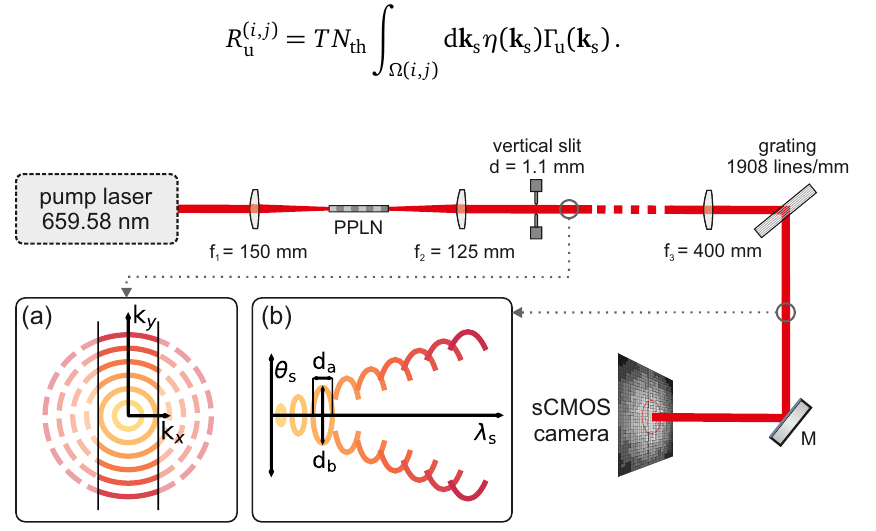
Figure 1: Layout of the experimental setup. Only the components used in the sim- ulations are included. f: lens. PPLN: periodically poled MgO-doped LiNbO M: mirror. Length of optical paths are not to scale. (a) represents a cross section of the spectrum after the slit. (b) sketches the separation of spectral components by the / d grating. The ratio d quantifies the asymmetry introduced in this a b